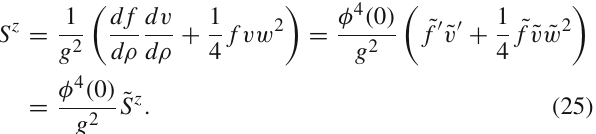
Fig. 7 The profiles of the color electric fields ˜ E 2 ϕ ≡ gE 2 ϕ /φ( 0 ) and ˜ E 5 ≡ gE 5 /φ 2 ( 0 ρ ρ